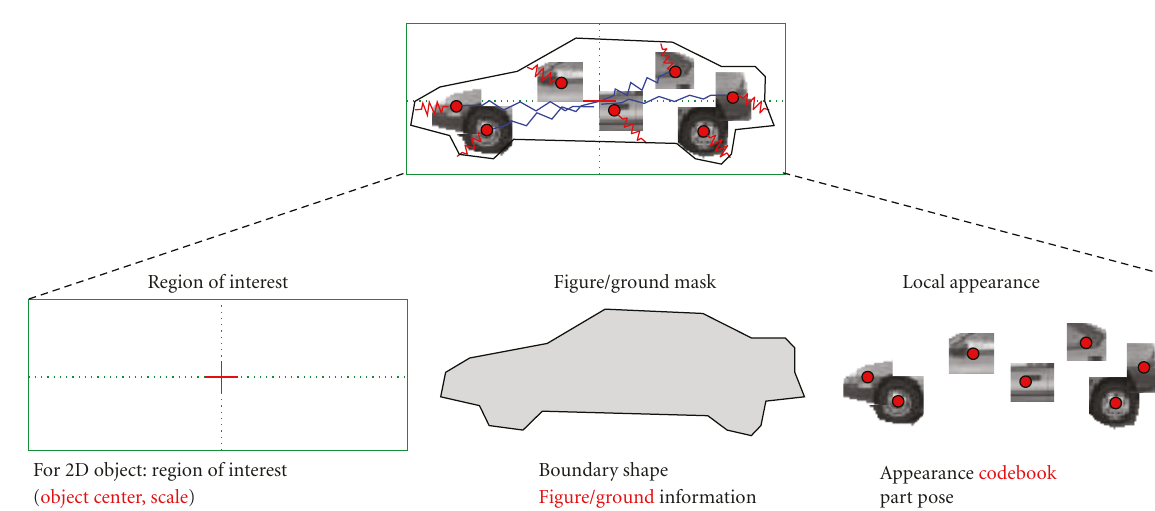
Figure 9: Basic representation of an object instance by region of interest (ROI), figure-ground mask, and local appearance.